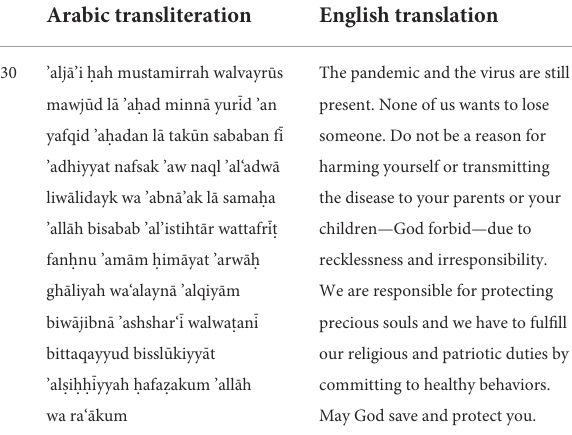
TABLE 12 Examples of the use of the liking–unity–commitment–social proof